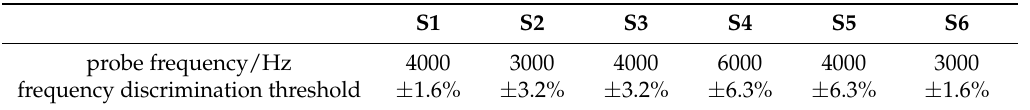
Table 2. The results of six subjects at the frequencies of the highest hearing